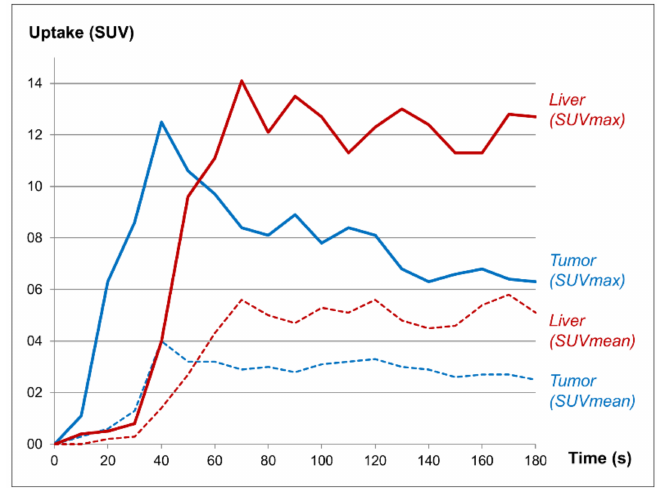
Figure 3. Measurements of standardized uptake values (SUV) in the tumor and in a liver segment not involved by tumor showed fast tumor perfusion followed by a “washout” of tracer (blue curves), while the liver uptake remained relatively steady (red curves).